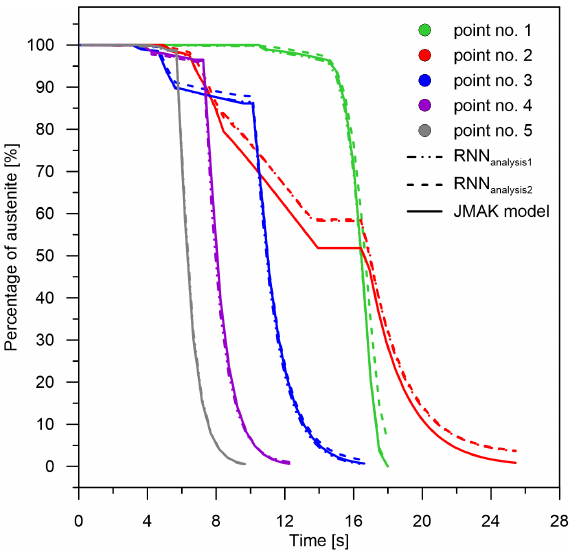
Figure 9. Phase transformation kinetics—analysis No. 1 and analysis No.